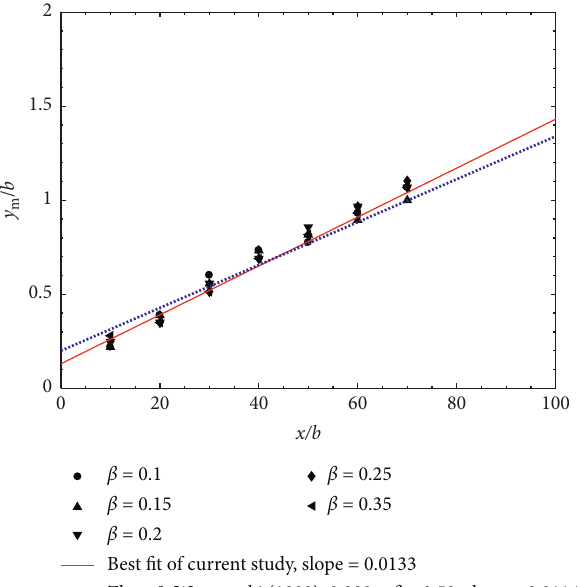
Figure 13: Rate of spread of y